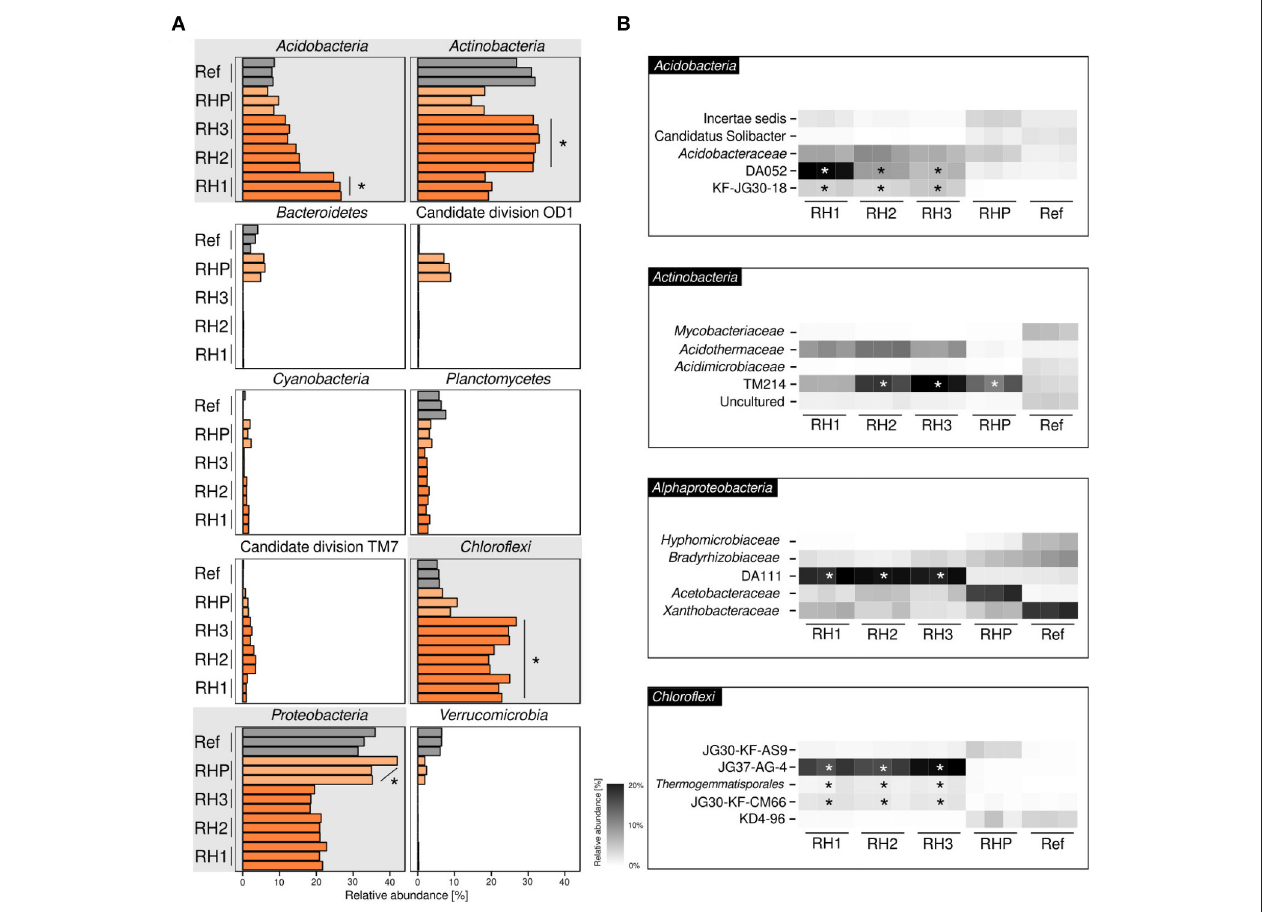
FIGURE 1 | Bacterial community profiling based on amplicon sequencing of bacterial 16S rRNA genes. Community profiles were obtained for three slag deposit sites (RH1-RH3), sediment of a pond collecting the slag drainage water of rainfall events (RHP) and nearby undisturbed forest soil (Ref). (A) Phylum-level analysis is shown for the ten most abundant bacterial groups. Panels linked to the four phyla showing highest abundances are emphasized in gray. Orange bars = RH1-3, light-orange bars = RHP, gray bars = Ref. (B) Taxonomically more resolved community profiles for the four most abundant phyla. *Significant enrichment ( p ≤ 0.05) based on one-way